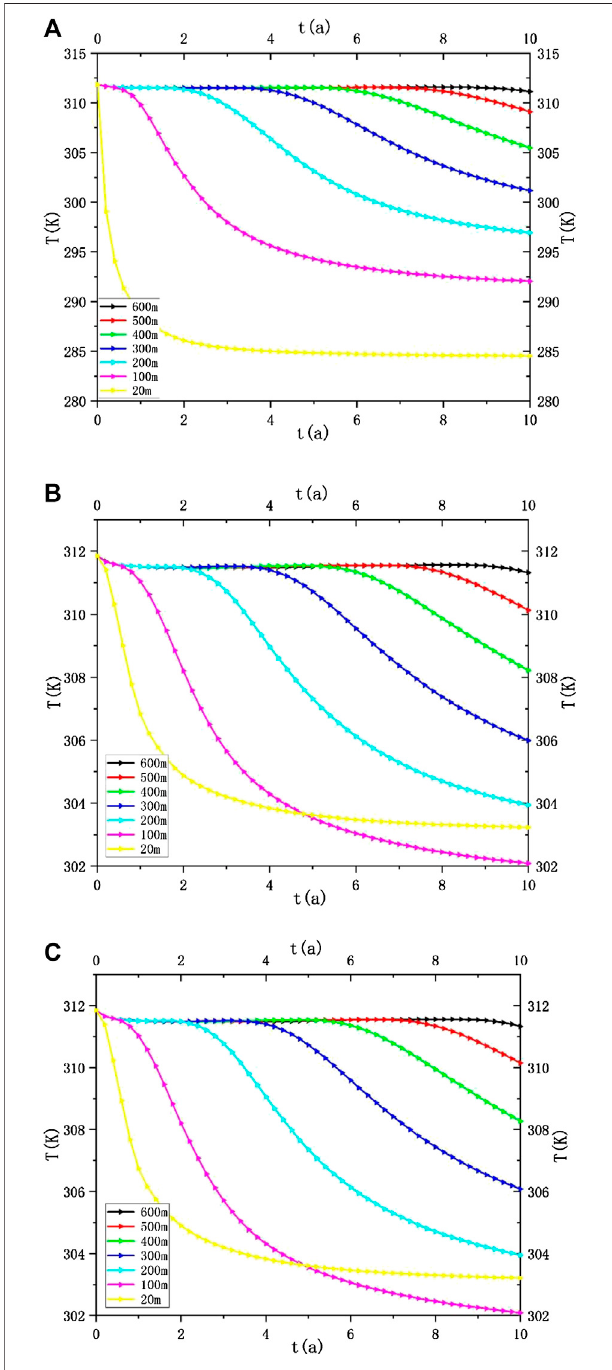
FIGURE 6 | Temperature changes of production wells at different spacings. (A) Temperature changesintheproductionwellwithonereinjection and one production. (B) Temperature changes in production well 1 with one reinjection and one production. (C) Temperature changes in production well 3 with one reinjection and one